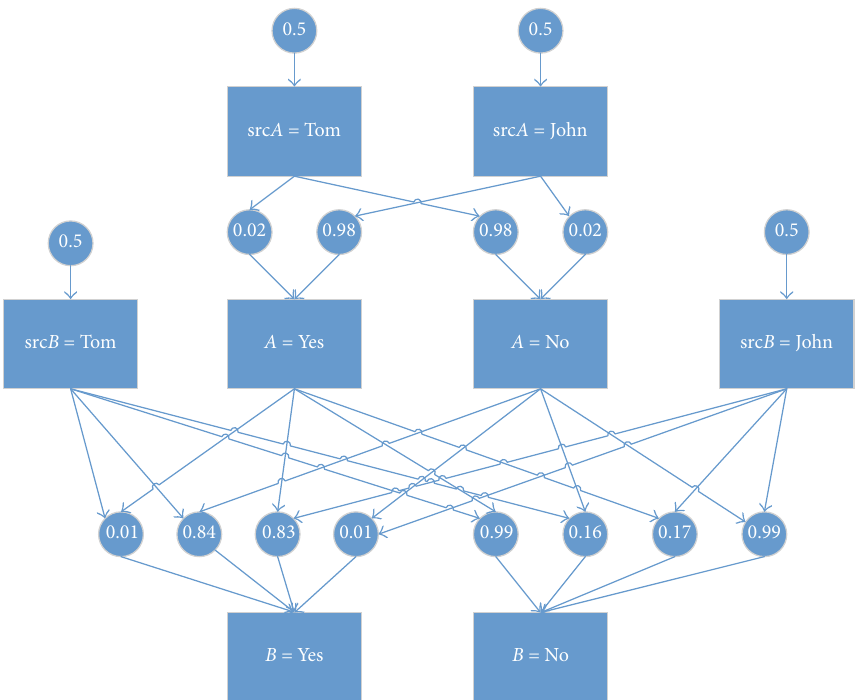
Figure 2: A fused BKB from BKB 1 and BKB 2.